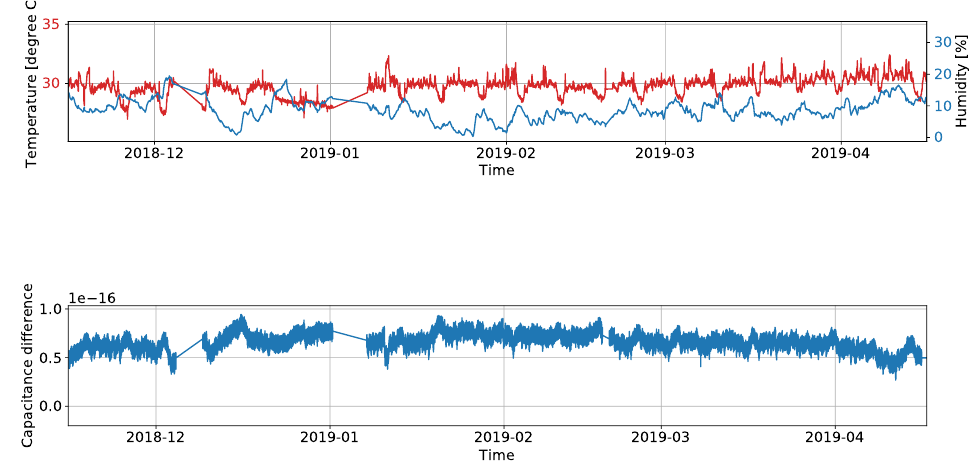
Figure 14. Temperature and humidity inside the electronics housing and reference capacitance difference measurement results of not connected channel of the